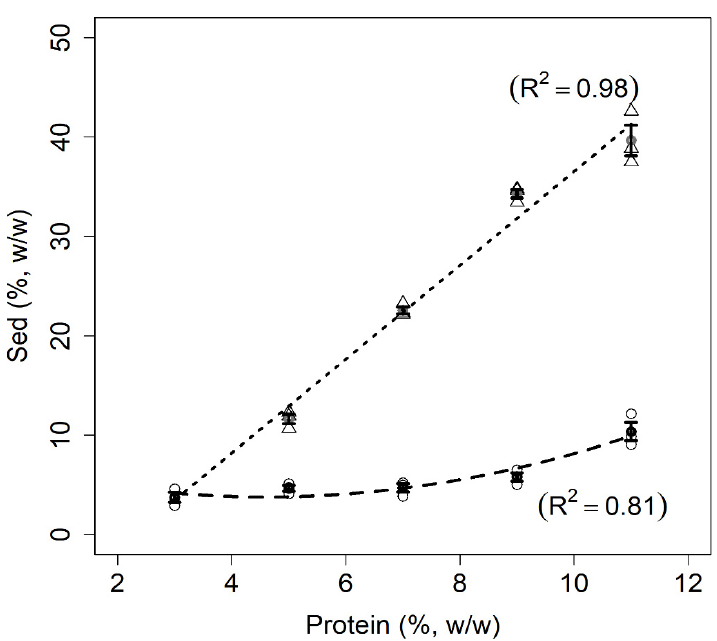
Figure 4. Relationship between sedimentable material (Sed % w/w ) and protein concentrations for milk (dashed line) and mixed protein (dotted line) samples. The figure shows the data points for milk (circles) and mixed samples (triangles), error bars (SE), fitted curves, and adjusted coefficients of determination (R 2 ).